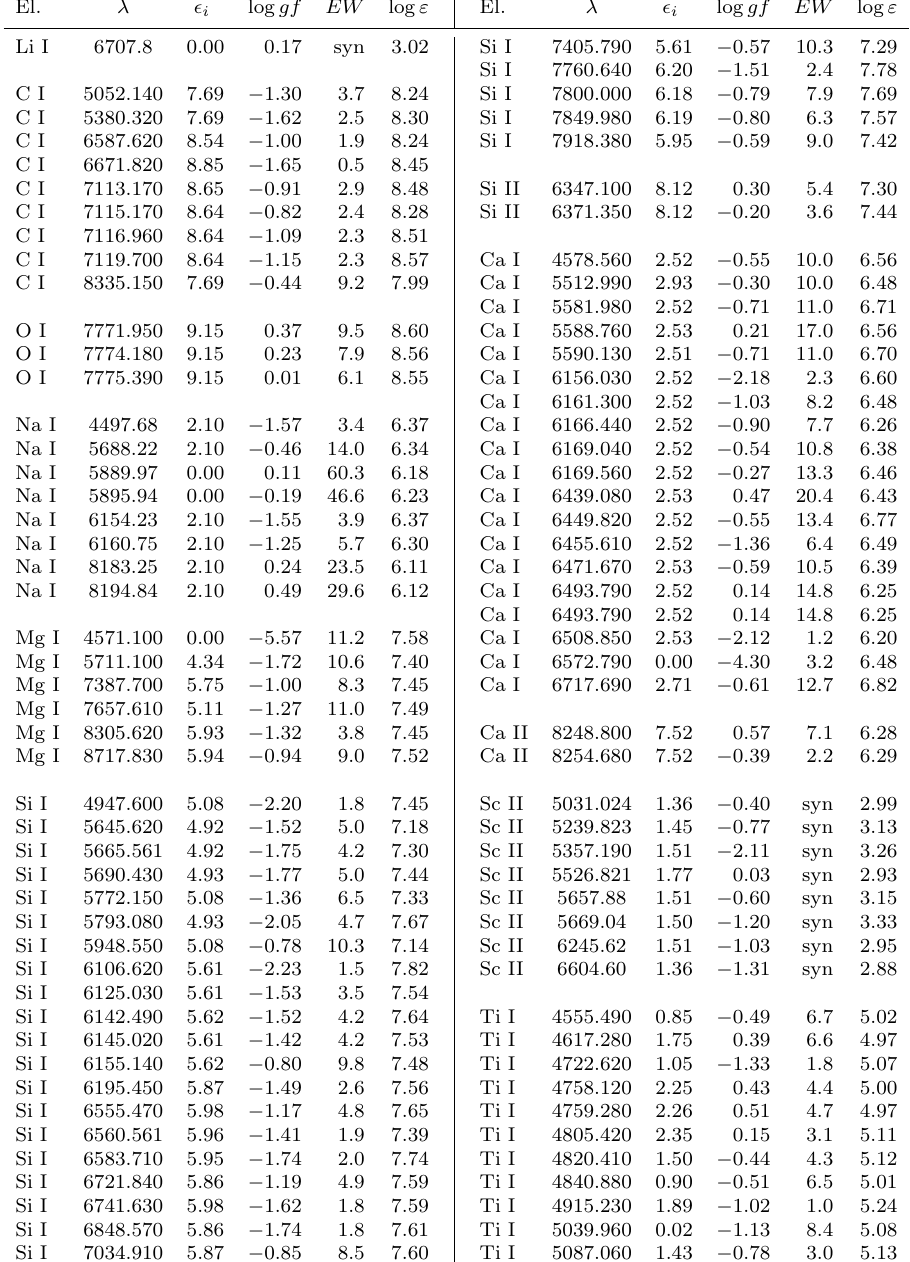
Table 3. Atomic data (wavelengths [˚A], lower level excitation potentials ϵ i [eV], oscillator strengths log gf ), equivalent widths [pm] and abundances calculated with the model parameters T eff = 5875 K, log g = 4 . 25 and ξ t = 1 . 8 km s (cid:0) 1 for HD 377.